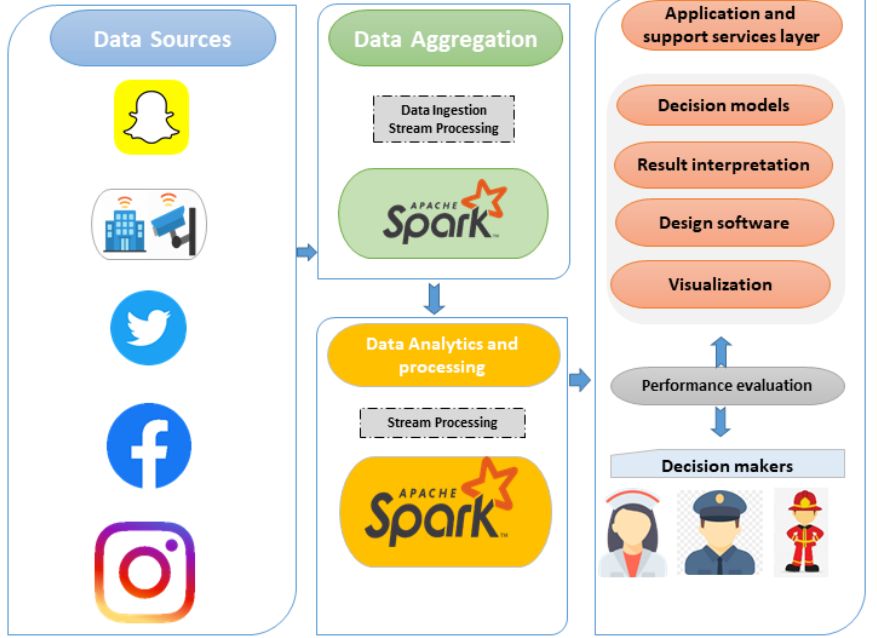
Figure 1. Overall of big data